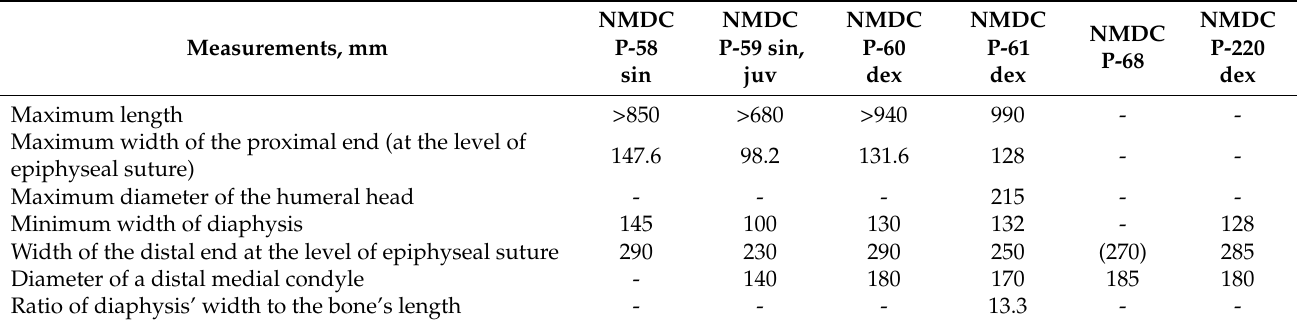
Table 2. Measurements of humerus of Mammuthus intermedius from Kamensk-Shakhtinskiy (the early Late Pleistocene; Rostov Region, Russia). Data in brackets are approximates.